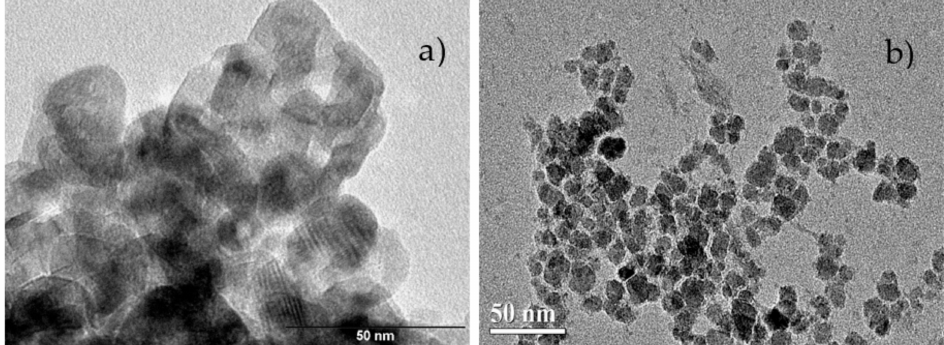
Figure 7. Transmission electron microscopy (TEM) image of nanoTiO 2 (bar length of 50 nm; a ) and nanoCeO 2 (bar length of 50 nm; b